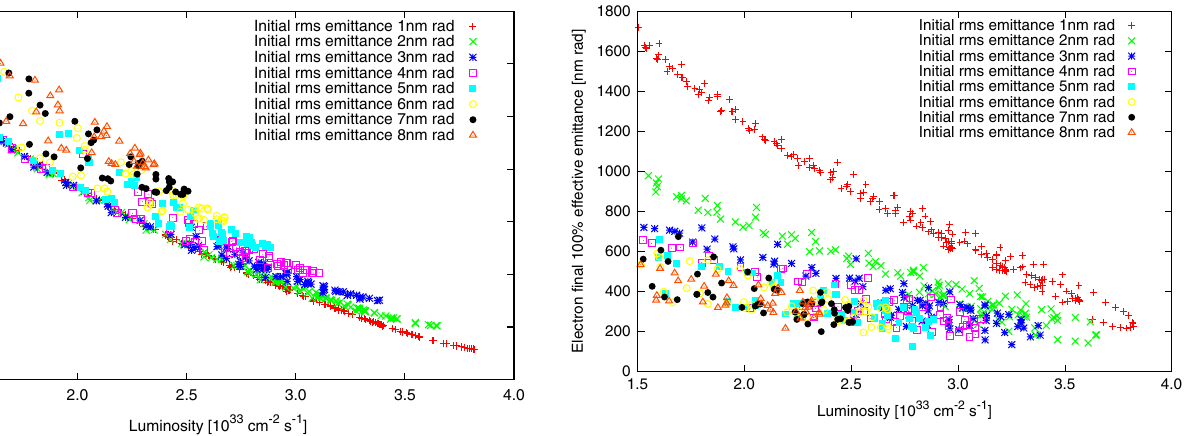
FIG. 10. (Color) Electron beam rms geometric emittance after collision as a function of